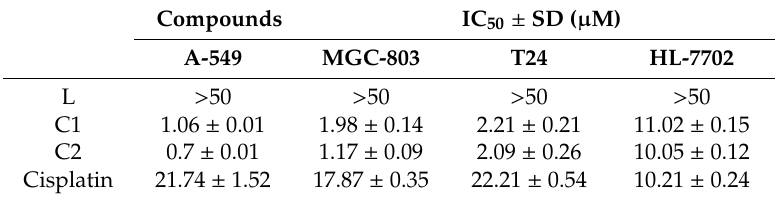
Table 2. IC 50 ( µ M) values of C1, C2, and Cisplatin toward cancer cells and normal cells for 48